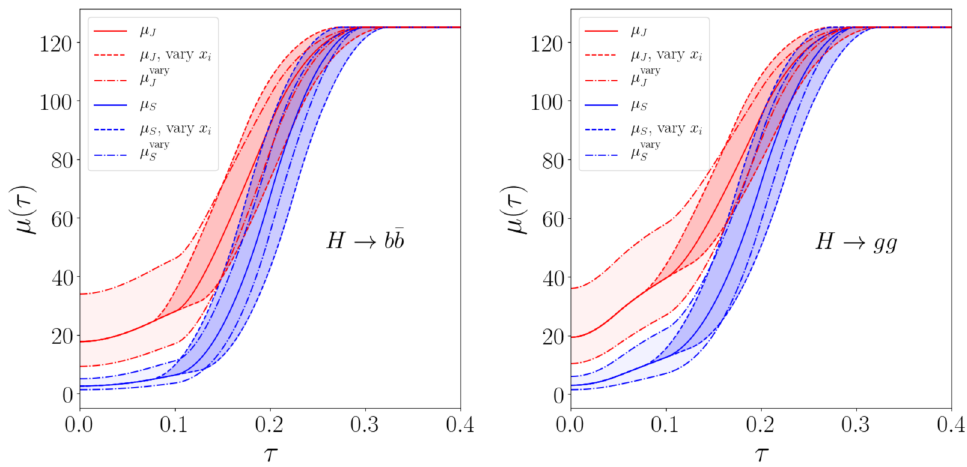
Figure 3. The profile scales from eq. (3.14) for the b (cid:22) b case (left) and gg case (right). The red (blue) curves show the jet (soft) scale (cid:22) J ( (cid:22) S ) and its variations. Variations due to shifts in the transition points x i are shown as dashed lines, while the variations in eq. (3.18) are shown as dashed-dotted lines. Variations of (cid:22) H result in an overall rescaling of these curves and hence are not